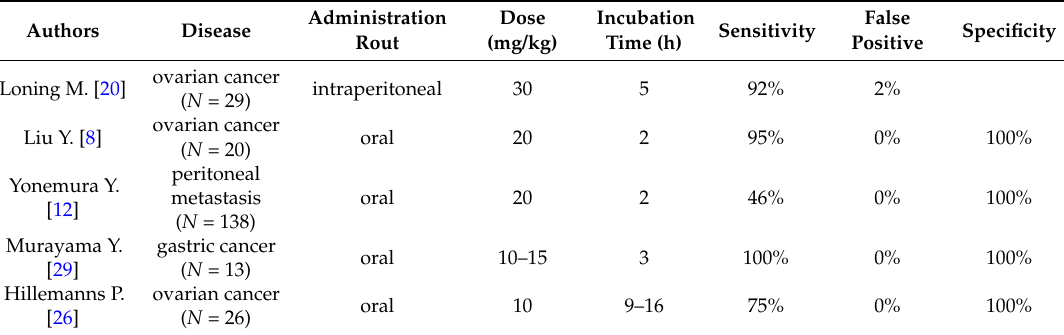
Table 5. Results of ALA PDD clinical trials for peritoneal metastasis. N = number of